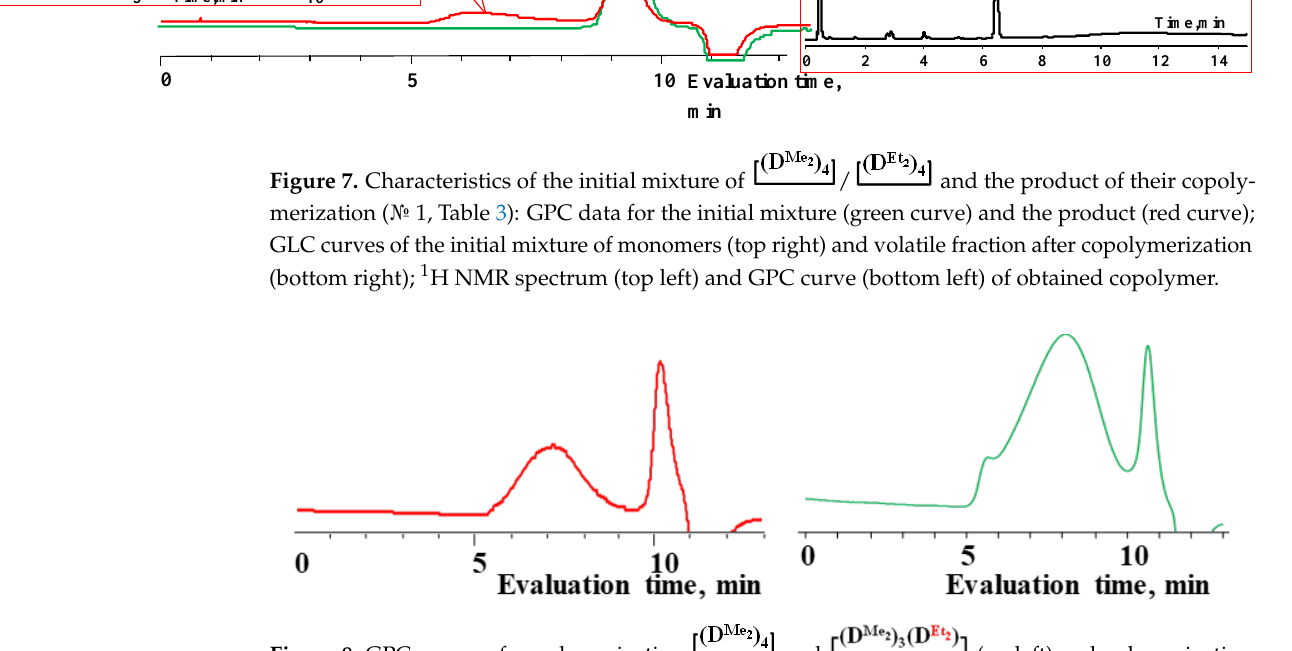
Figure 8. GPC curves of copolymerization and (on left) and polymerization (on right) products.